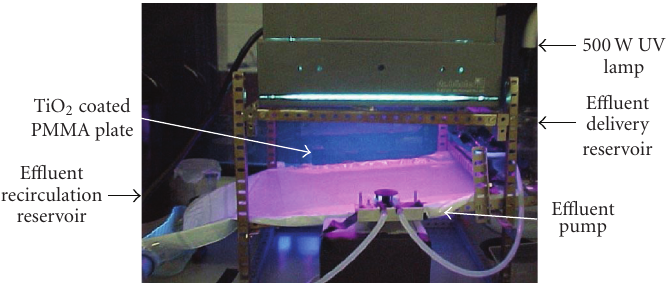
Figure 1: Prototype flat plate reactor treatment system under a UV